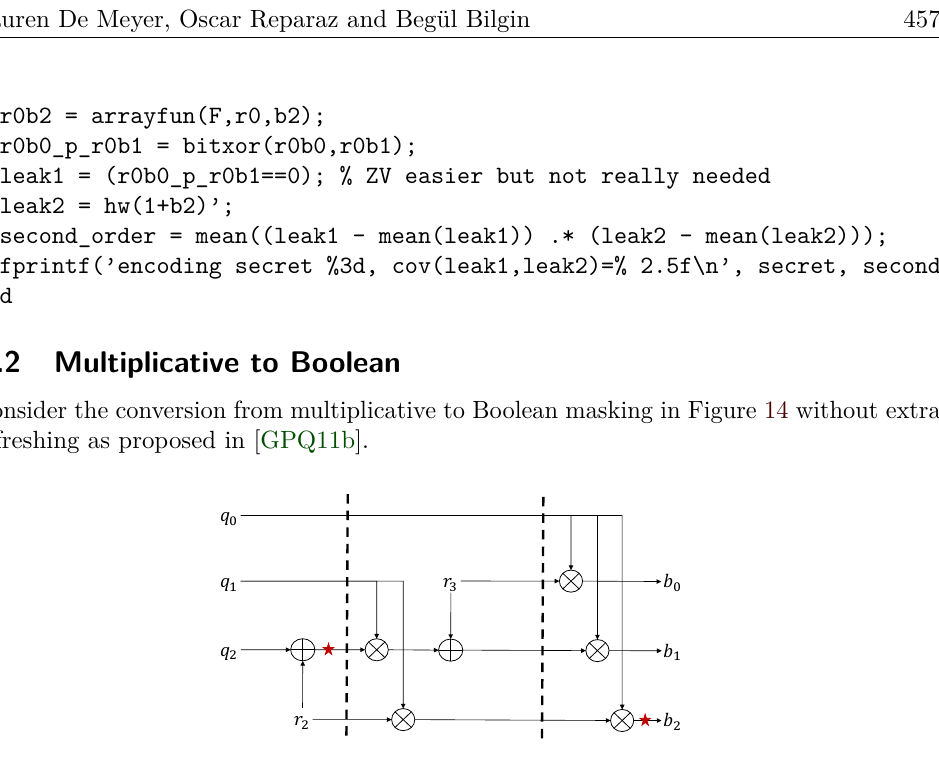
Figure 14: Conversion from multiplicative to Boolean masking with second-order leakage The pair of intermediates ( V 1 , V 2 ) with V 1 = q 2 ⊕ r 2 and V 2 = q 0 q 1 r 2 (as indicated by the red stars in Figure 14) leaks information in the second statistical order. For instance, whenever V 1 = 0, then V 2 = q 0 q 1 q 2 = x reveals information on the sensitive variable x . The following MATLAB script shows that the second-order statistic E [ L 1 ( V 1 ) · L 2 ( V 2 ) | X = x ] varies as a function of the secret x